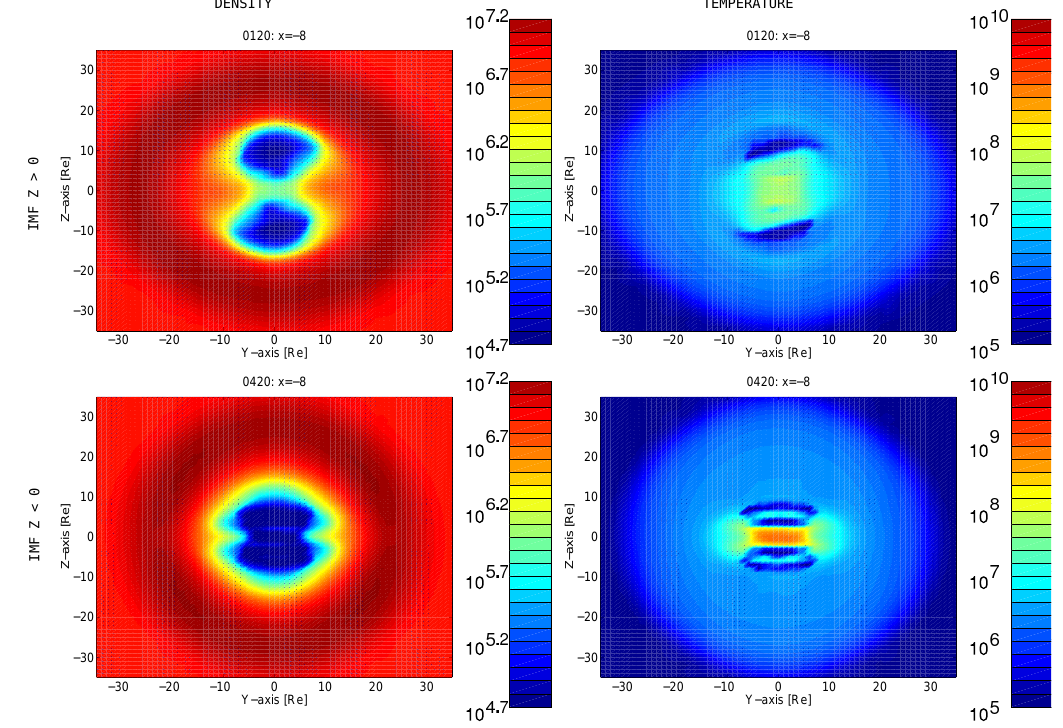
Fig. 10. Logarithm of density (left) and temperature (right) in the GUMICS-4 simulation at X = − 8 R E , within the simulation plasma sheet. First row shows the parameters for northward IMF (locally at − 8 R E ), while the second row is for southward IMF. The color bars range from 10 4 . 7 to 10 7 . 2 #/m 3 for the density, and from 10 5 to 10 10 K for the temperature. The figure is from Run